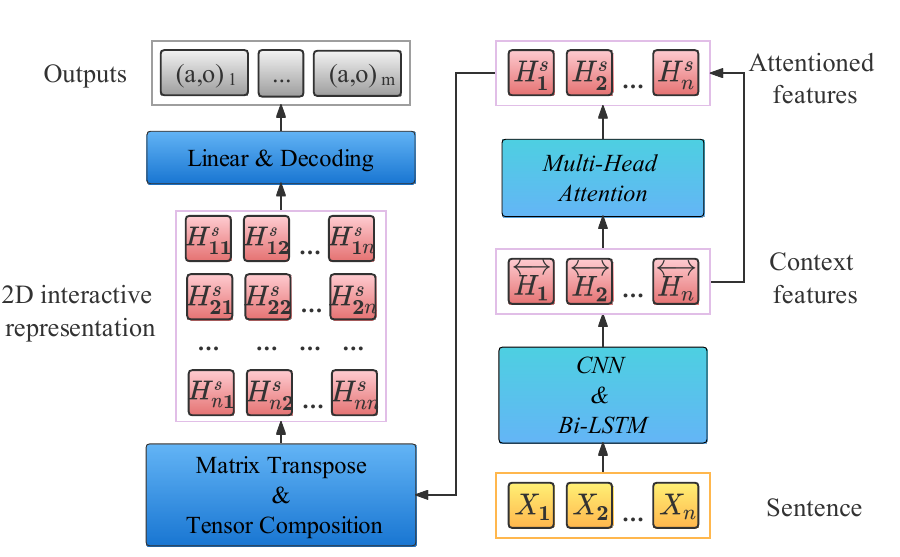
Figure 6. Architecture of the classifier. This model incorporates 2D interaction representation and grid-formed tagging schema [28] to extract all aspect and opinion phrases in a sentence.